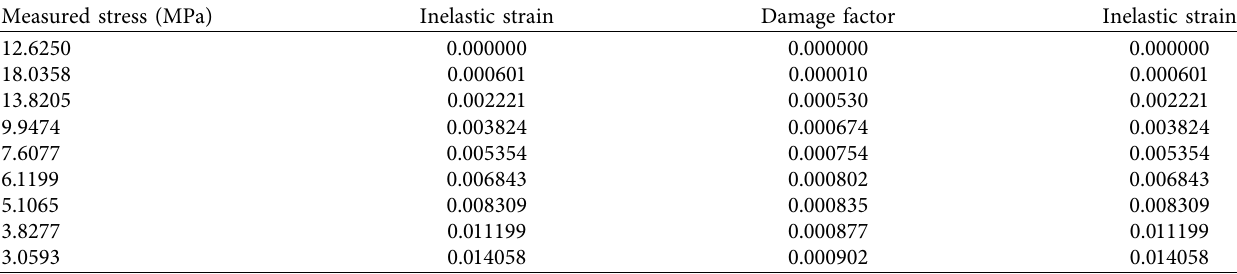
Table 1: Plastic constitutive model of concrete under compressive damage under 1.5 million fatigue loads.